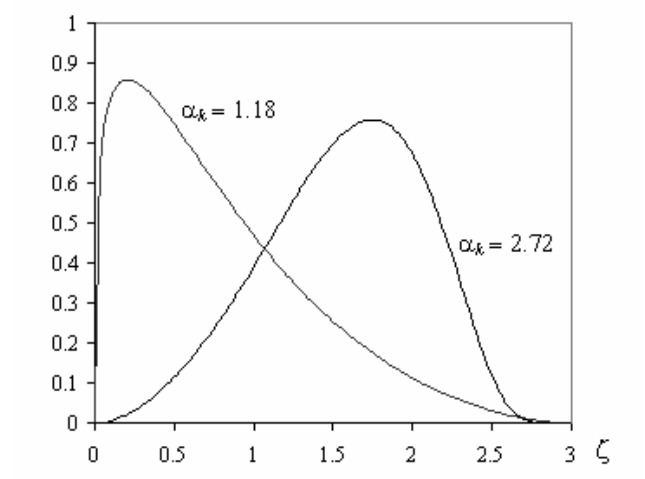
(cid:32) 0, (cid:86) (cid:32) k k